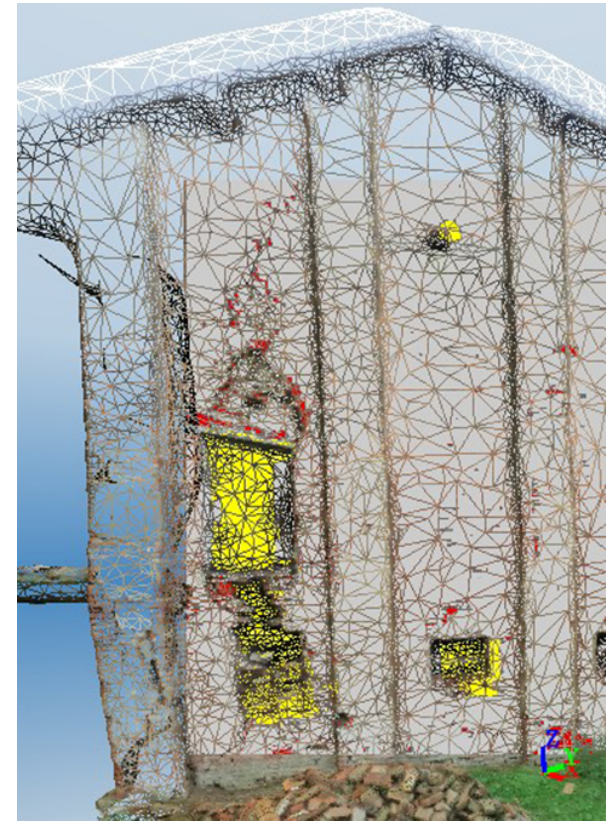
Figure 13. Example of the wire mesh with OBIA extracted infor- mation overlaid. Yellow indicated holes, and red indicated cracks in the façade (for better contrast, the color scheme was changed from the previous